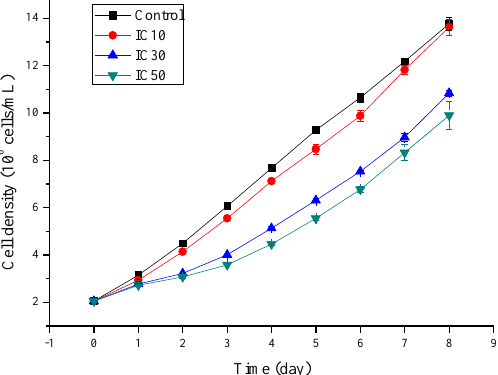
Figure 1. Growth curves of Scenedesmus obliquus exposed to different concentrations of tetracycline for 8 days.